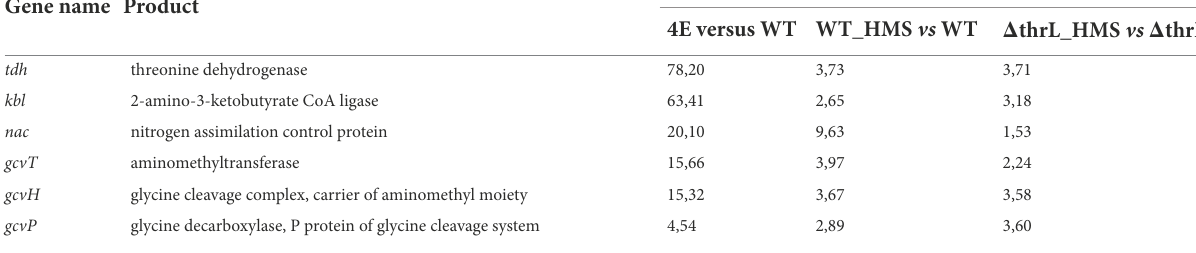
TABLE 3 The transcription factor encoded by nac potentially responsible for transcriptional activation of genes of the TDGII and GCS pathway in response to